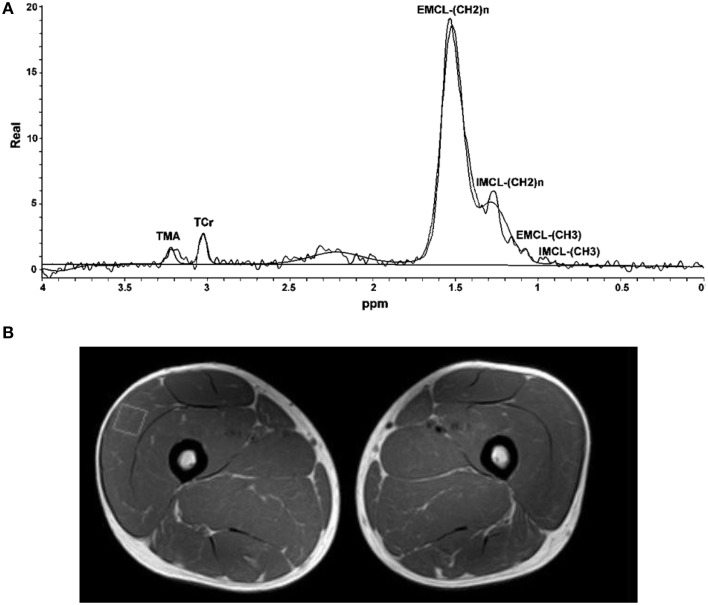
1H-MRS spectra of skeletal muscle and fitted data (A). Placement of voxel for spectroscopy in vastus lateralis. Square in MR image shows the position of the 1H-MRS voxels of leg muscles examined (B). EMCL, Extramyocellular lipid; IMCL, Intramyocellular lipid; Cr, Creatine (creatine + phosphocreatine).